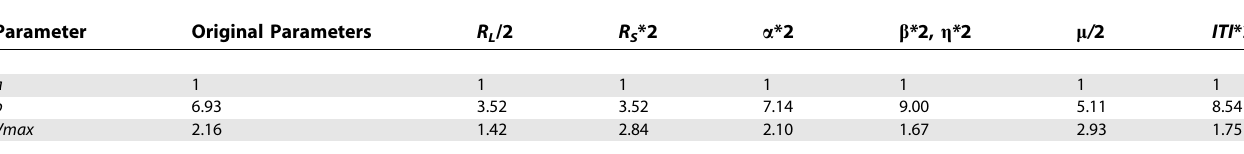
Table 1. Parameter Sensitivity Analysis Parameter Original